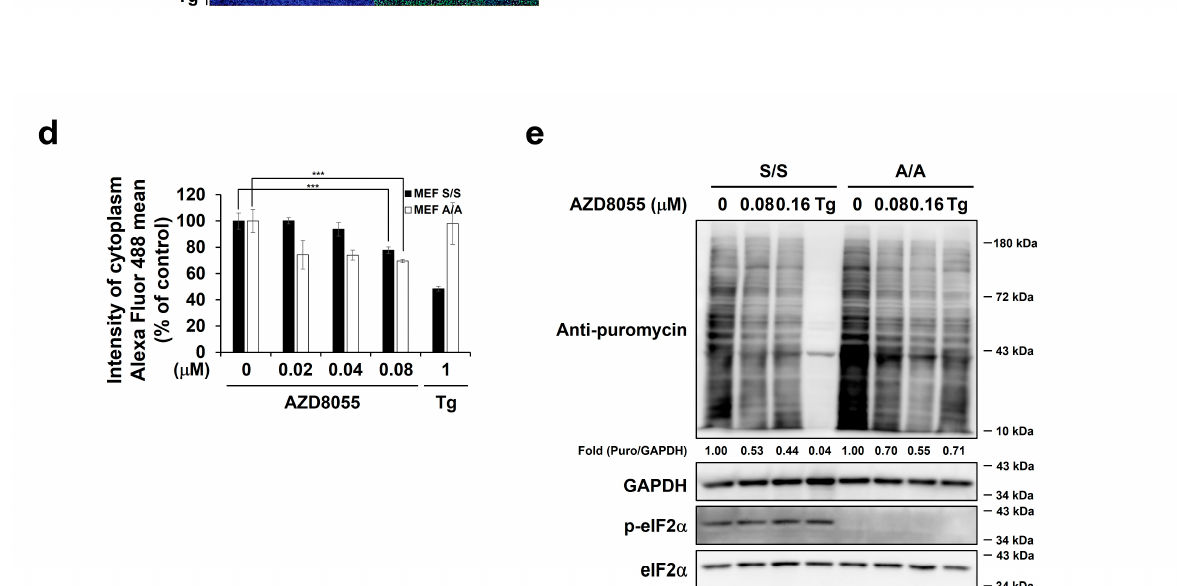
Figure 1. Screening anticancer drugs for identification of translation inhibitors. ( a , b ) The level of translation in mouse embryonic fibroblasts (MEFs) was measured using puromycin incorporation assay. Polypeptide chains in wild ‐ type MEFs treated with 10 µ M ( a ) or the indicated concentrations ( b ) of Selleck Anti-cancer Compound Library for 24 h were labeled with puromycin for 10 min. The number of cells (left column) and Alexa Fluor 488 intensities of each area (right column) were assessed using Operetta High ‐ Content analysis system. Operetta images were analyzed using Harmony software.